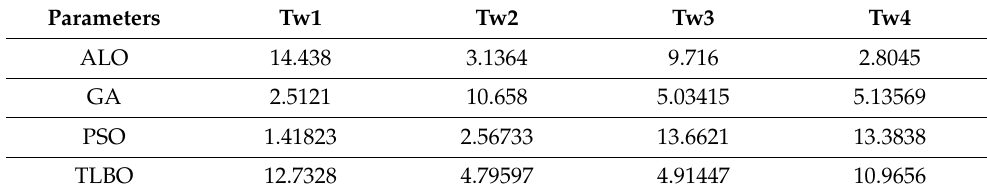
Table 7. Parameter values of washout time constant for dual-input